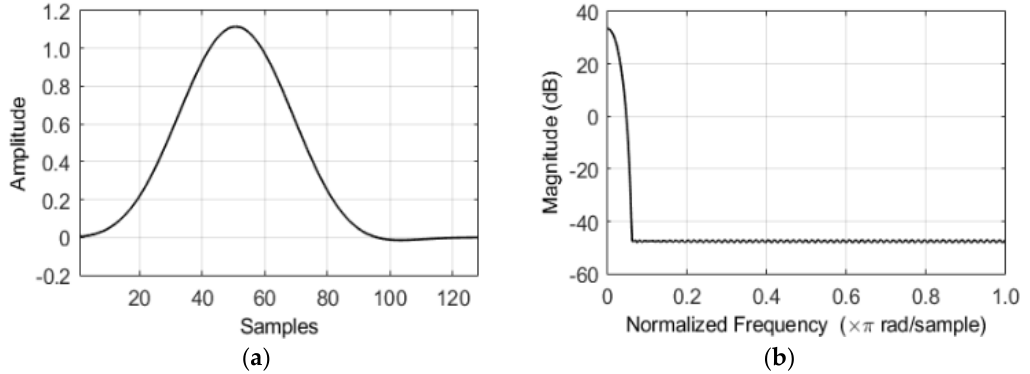
Figure 2. ( a ) The impulse response of a low pass filter prototype with 128 sample points and ( b ) its magnitude spectra at the normalized frequencies. The relative sidelobe attenuation is -80.5 dB.